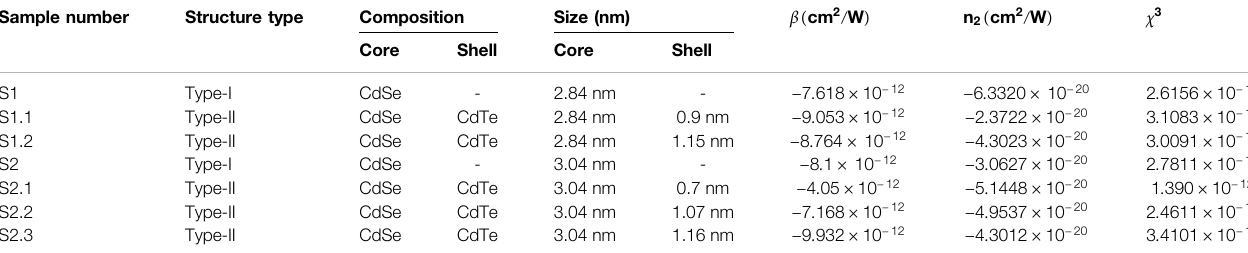
χ 3 by using fs laser z/scan technique [123]. 2 , and